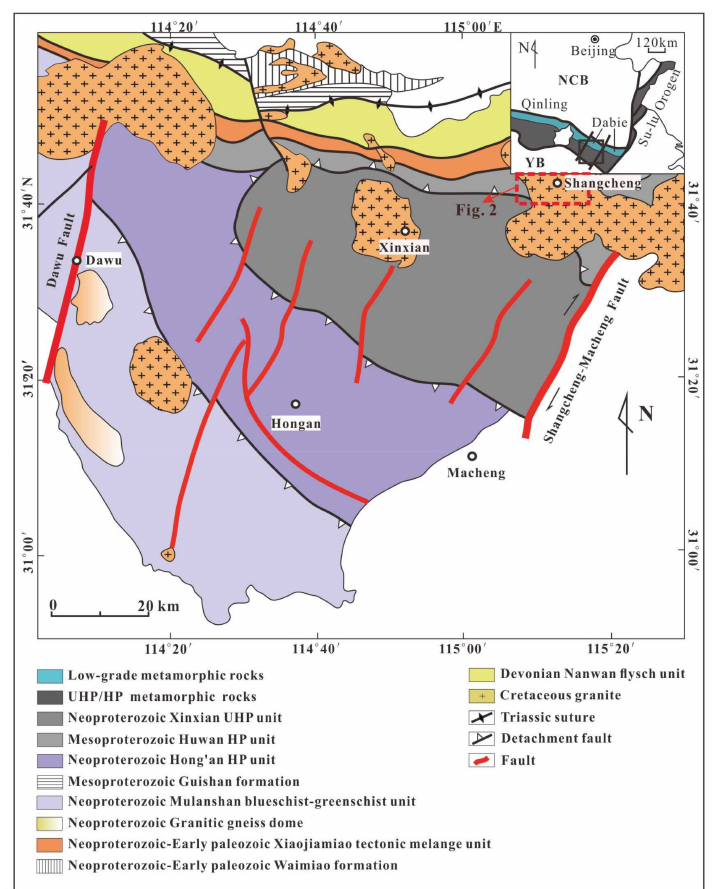
Figure 1. Geological map of the western Dabie orogen (modified after